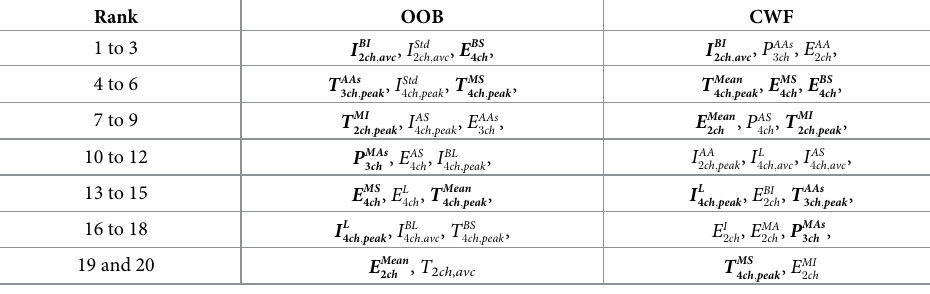
Table 3. List of the 20 most important features estimated using OOB and CWF.